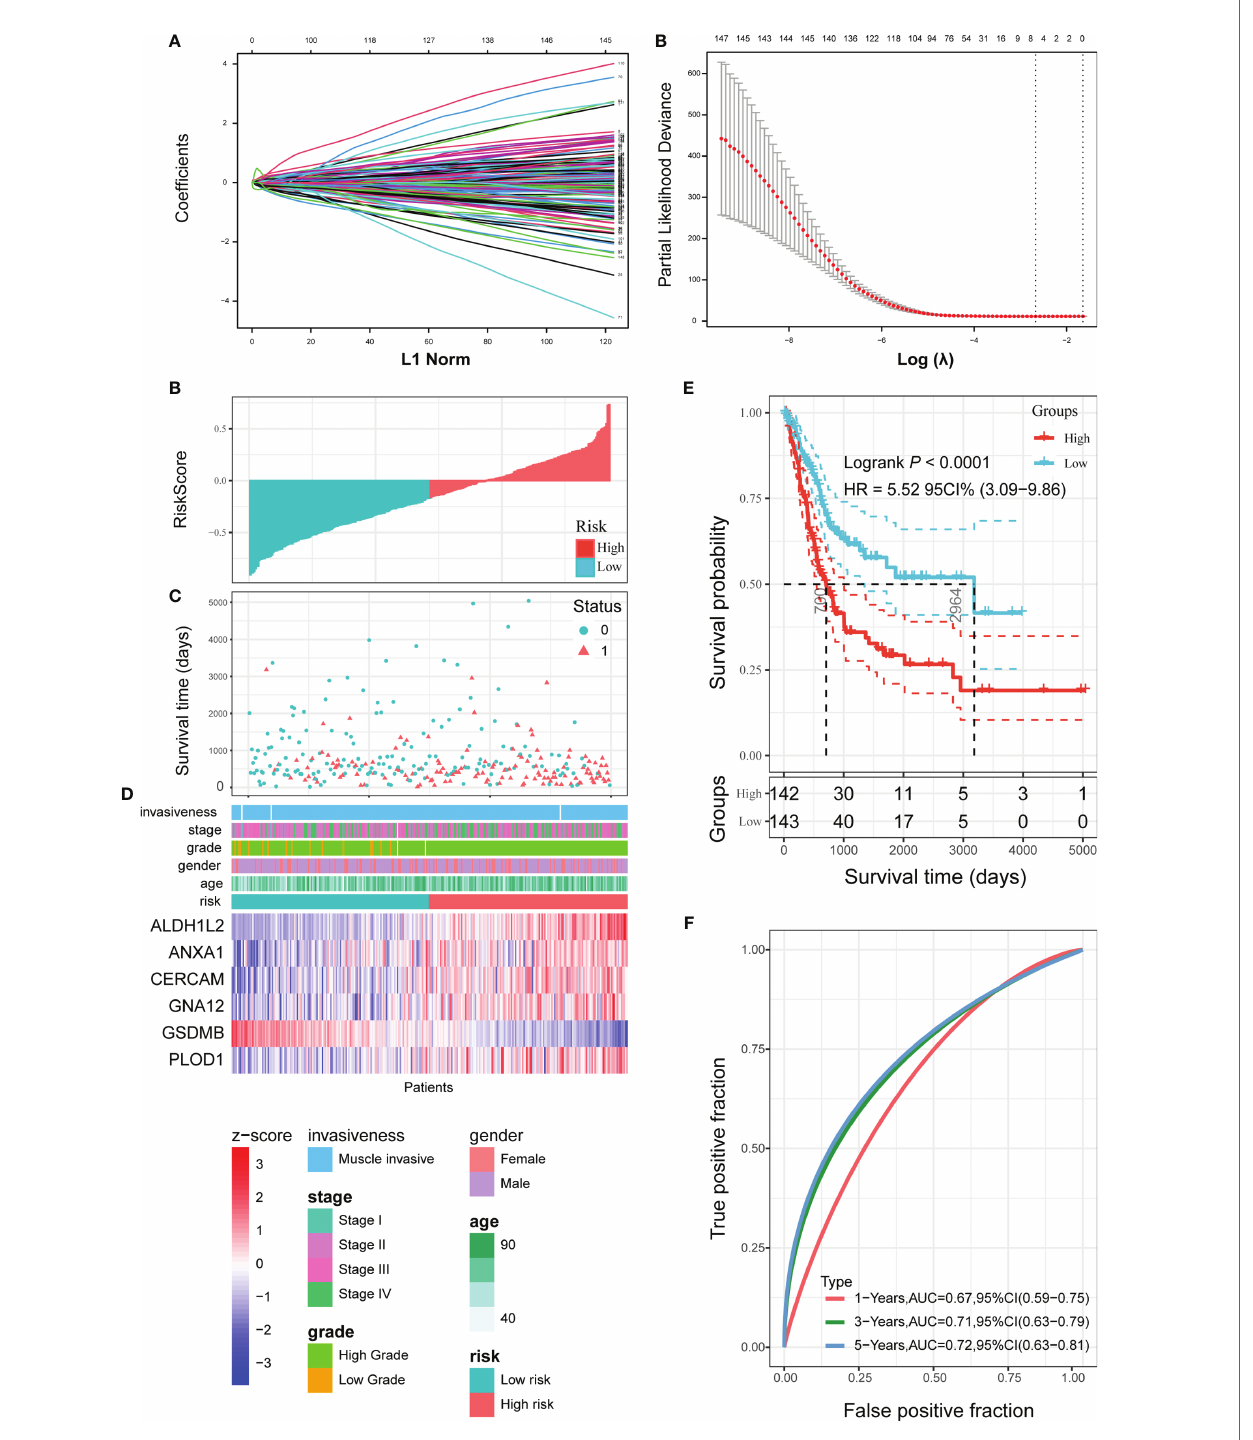
FIGURE 5 | Construction and analysis of risk signature based on PVR -related genes in the training set. (A) LASSO analysis with eligible lambda value. (B, C) Risk score and survival status of each patient in the training cohort. (D) Expression pattern of six candidate PVR -related genes in the high- and low-risk groups, annotated with corresponding clinicopathologic characteristics. (E) Kaplan-Meier analysis of patients in the high- and low-risk groups. (F) Time-dependent ROC analysis of risk score in predicting